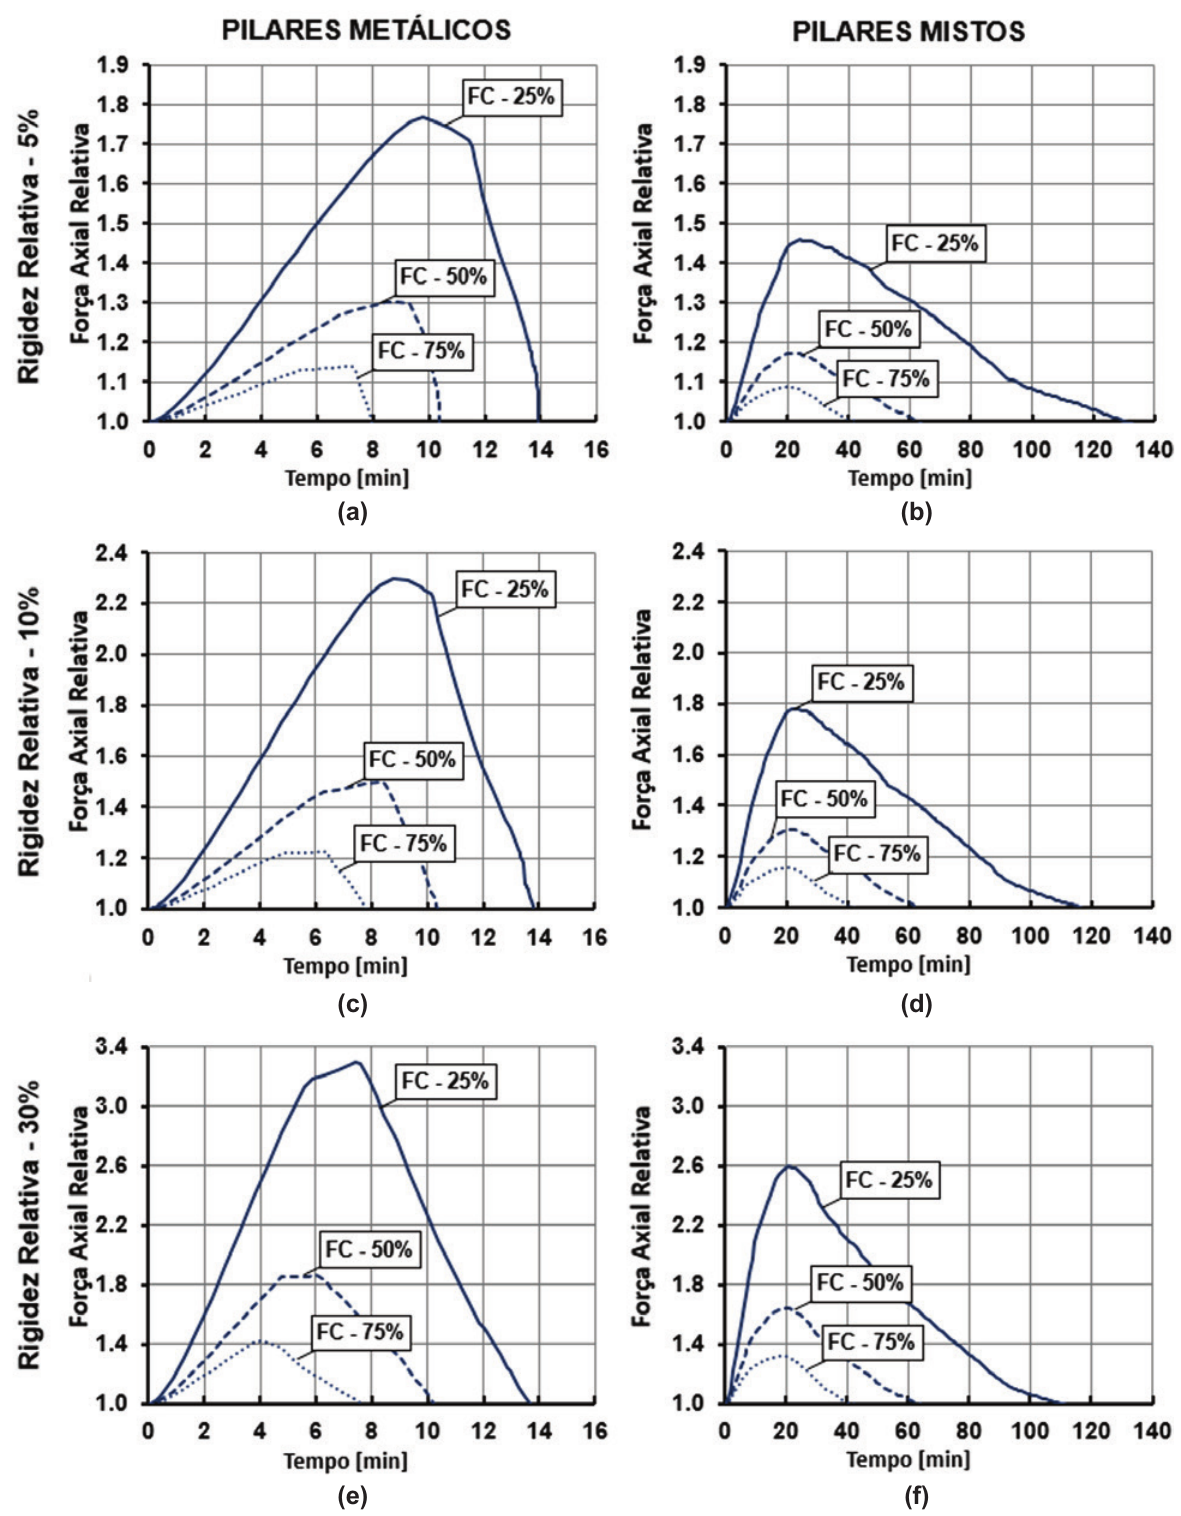
Influência da variação do fator de carga no desenvolvimento das forças axiais relativas para os pilares de aço e